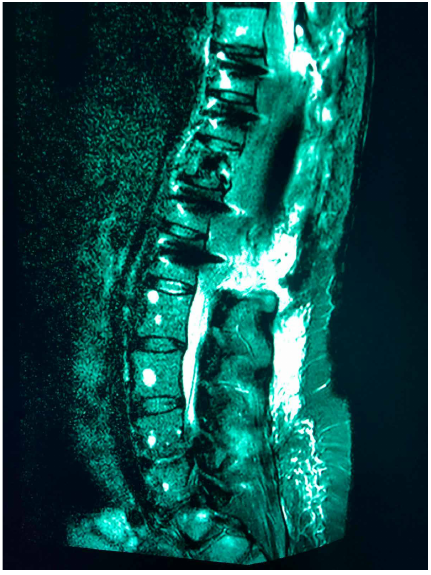
Figure 4: Mammogram MLO view showing dense breasts (inconclusive).